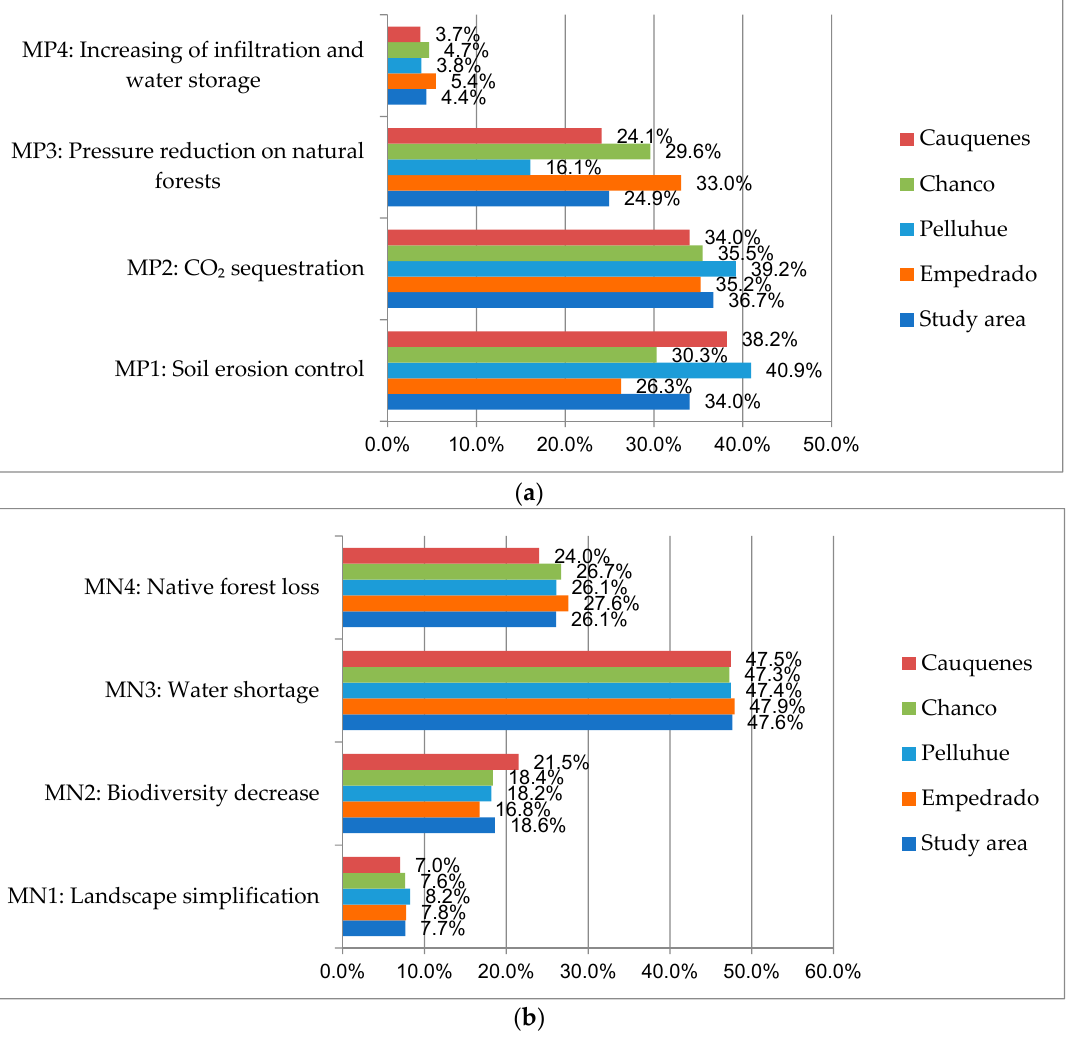
Figure 6. Environmental externalities: comparison among municipalities ( a ) positive externalities; ( b ) negative externalities.